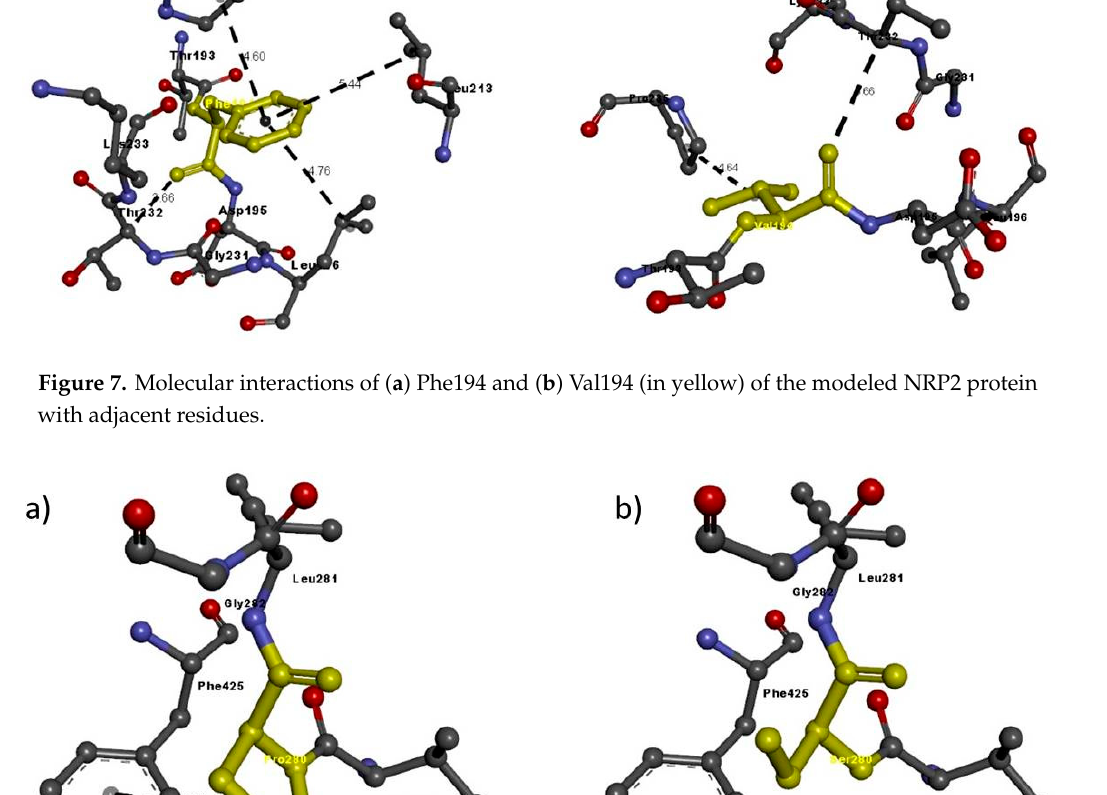
Figure 8. Molecular interactions of ( a ) Pro280 and ( b ) Ser280 (in yellow) of the modeled NRP2 protein with adjacent residues.